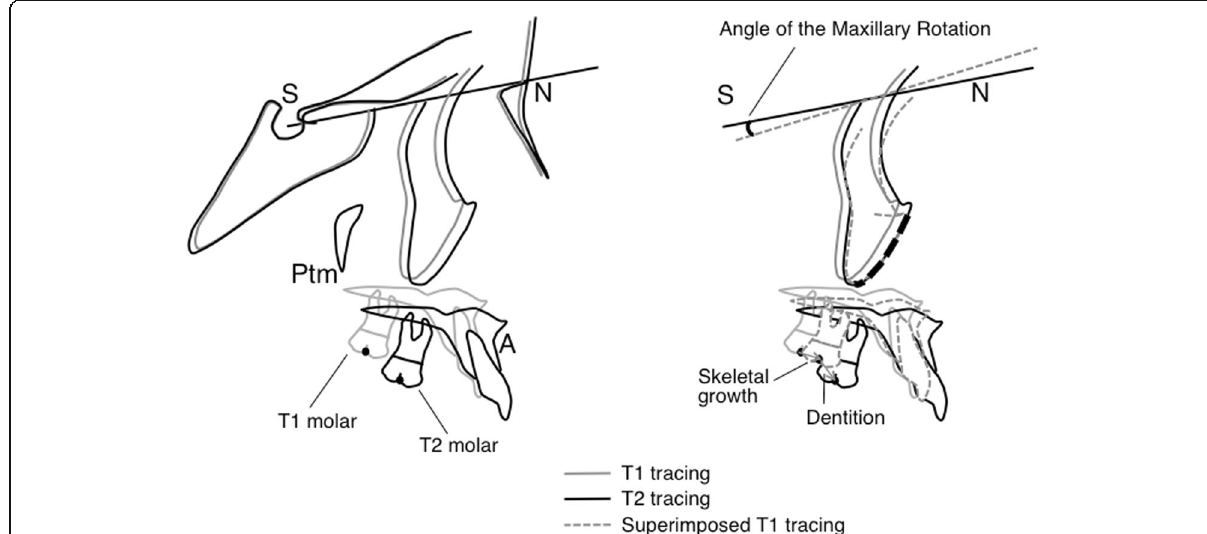
Fig. 1 Left: Superimposition of pre-treatment (initial, T1) and posttreatment (final, T2) tracings on the cranial base. Right: Superimposition of T1 and T2 tracings on the maxillary internal stable structure, the anterior contour of the zygomatic processes (shown by a black broken line). The maxillary dental component and maxillary skeletal component are represented. The maxillary rotation was measured as the angle between the sella-nasion (SN) lines of T1 and T2 tracings on the superimposition. Ptm: the pterygomaxillary fissure; A: point A